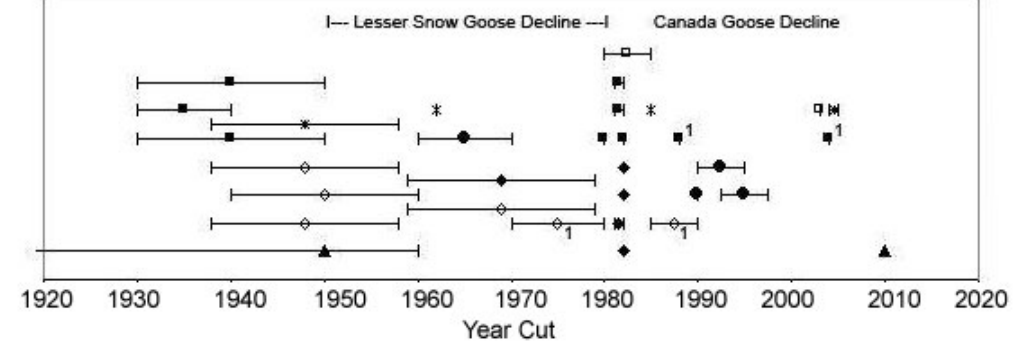
Fig. 3 . Tuuhiikan cut dates displayed by hunting territory. X–error bars represent the range of date reporting. For example, a tuuhhikan cut in the early 1980s is centered at 1982.5 ± 2.5 yrs. A tuuhiikan cut in the 1980s is centered on 1985 + or – 5yrs. n = 32 (30 +2). Cut dates were recorded for 30 tuuhiikaan , however, two tuuhiikaan were re-cut and increased and are represented as a second cut date in the Figure. The labels “Lesser Snow Goose decline” and “Canada goose decline” are situated to indicate the time periods at which these events were reported. Hunting territory or trapline codes have no relation to spatial distribution of